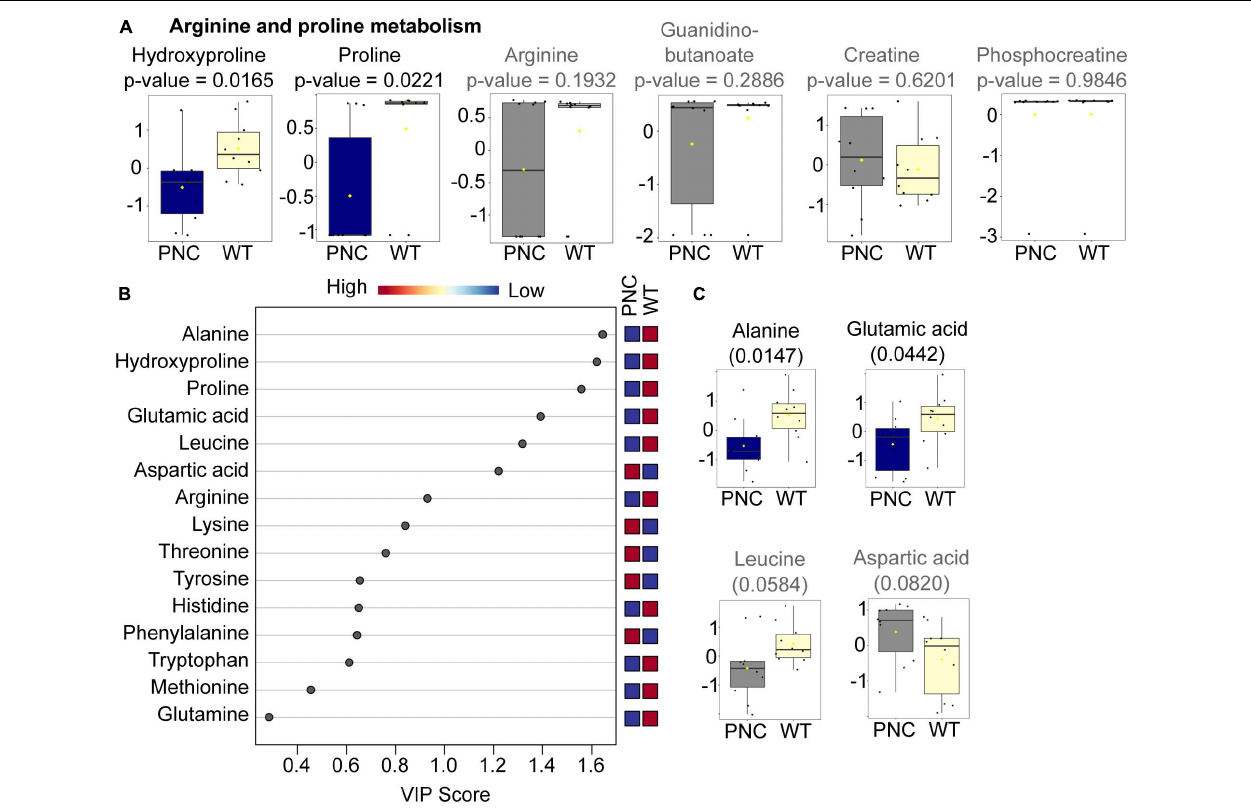
FIGURE 6 | Amino acids significantly altered upon HRAS G12V induction in PNCs. (A) Box and whisker plots generated using MetaboAnalyst 5.0 online platform for arginine and proline metabolism, identified using pathway enrichment analysis. (B) Variable importance in projection (VIP) plot generated using MetaboAnalyst 5.0 online platform for the 15 amino acids identified in our dataset. The relative abundance of each amino acid in the preneoplastic cell (PNC) and control (WT) groups are presented as colored boxes ranging from blue (low) to red (high). The average for N = 10 is presented. (C) Box and whisker plots for the four amino acids with a VIP cut-off score of 1, except hydroxyproline and proline presented in (A) . The altered metabolites with statistical significance ( p < 0.05) are presented in blue and the non-significant metabolites in gray. The boxplots represent median ± interquartile range of log transformed and auto-scaled intensities for preneoplastic cell (PNC) and control (WT) groups ( N =